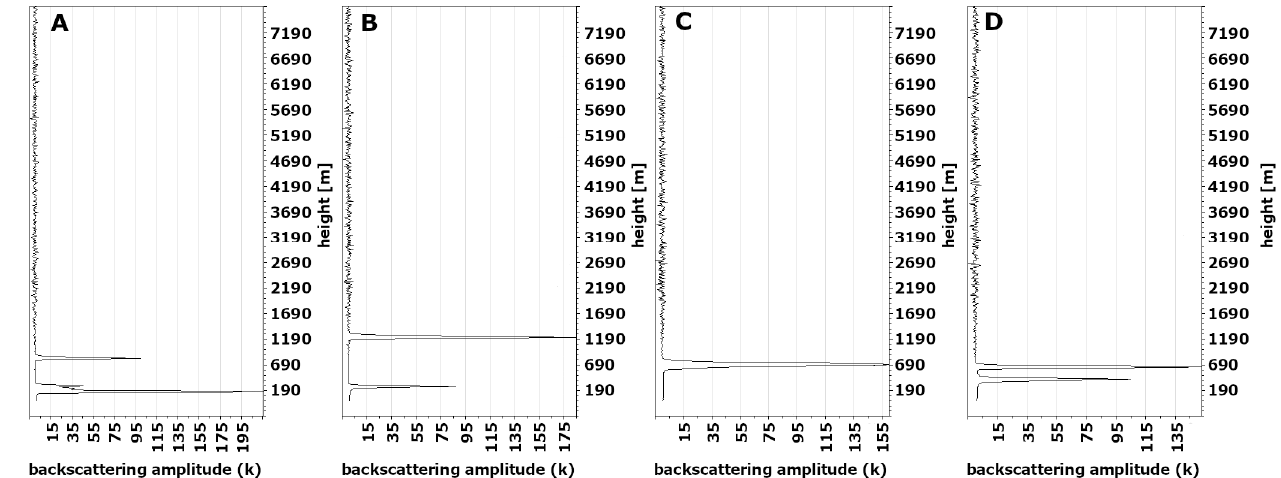
Figure 4. A selection of backscattering amplitudes from ceilometer measurements on 3 October 2007 (( A ): Porvoo, 3 October 2007 18:13 UTC; and ( B ): Helsinki, 3 October 2007 19:21 UTC) and 5 October 2007 (( C ): Nurmijärvi, 5 October 2007 18:26 UTC; and ( D ): Nurmijärvi, 5 October 2007 19:22 UTC), showing heights of cloud layers. For ceilometer locations, see map of Figure 1.